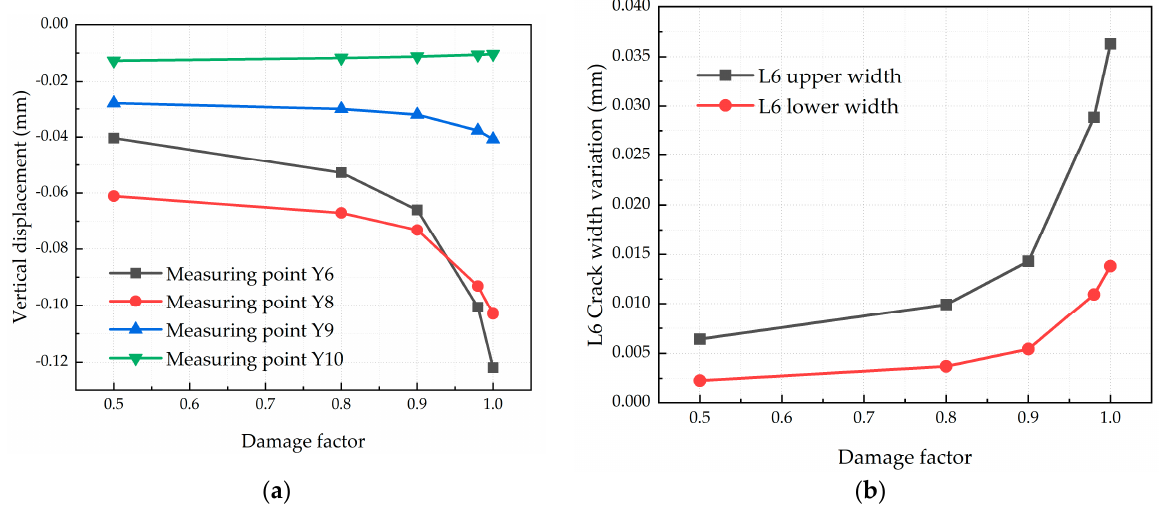
Figure 18. ( a ) Variation curve of the vertical displacement of each measurement point with the damage factor of cracked slates; ( b) variation curve of the increase of the L6 crack width with the damage factor of cracked slates